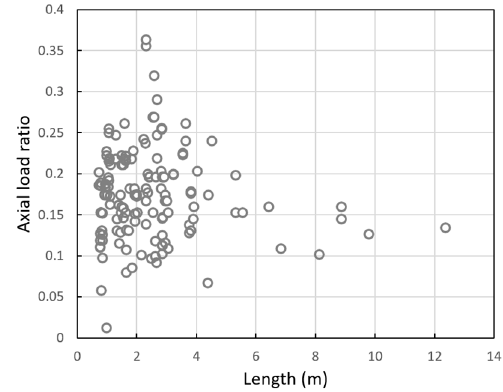
Figure 2. Axial force ratio by wall length.